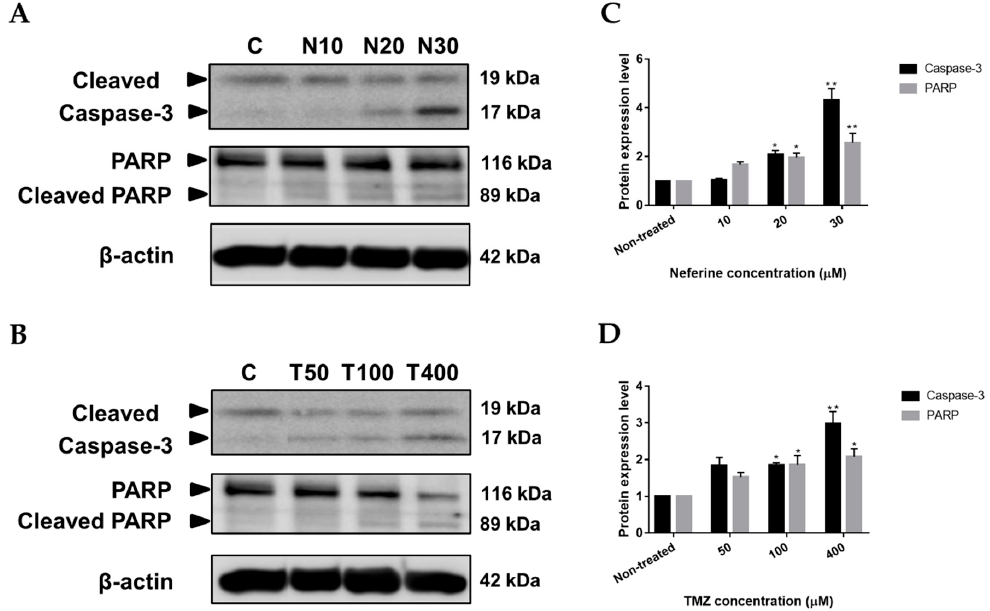
Figure 5. Neferine induces apoptosis in human neuroblastoma cells. ( A , B ) IMR32 cells were incubated at the described concentrations of neferine ( A ) or TMZ ( B ) for 24 h. Then, apoptosis-related proteins, including cleaved Caspase-3 and PARP, were determined using Western blot analysis; ( C , D ) Changes in the levels of cleaved Caspase-3 and PARP after being normalized to the levels of beta actin were displayed. Data are shown as mean ± SD in three independent experiments. * p < 0.05, ** p < 0.01 as compared with the non-treated